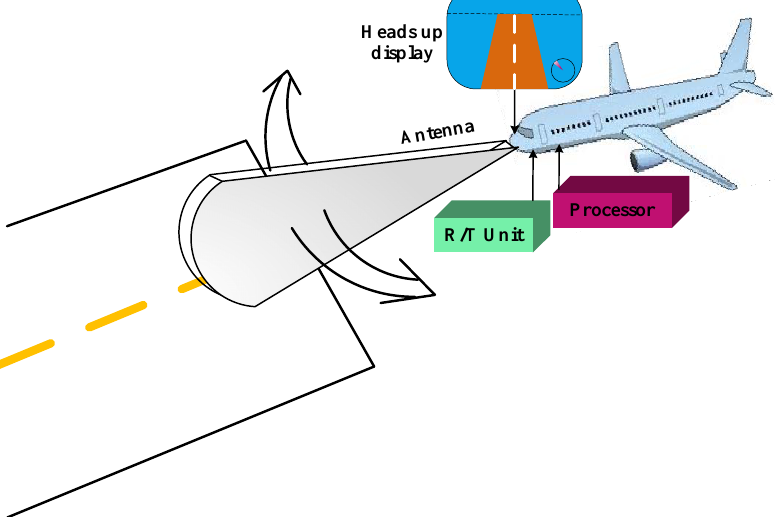
Figure 1. The diagram of scanning radar for aircraft